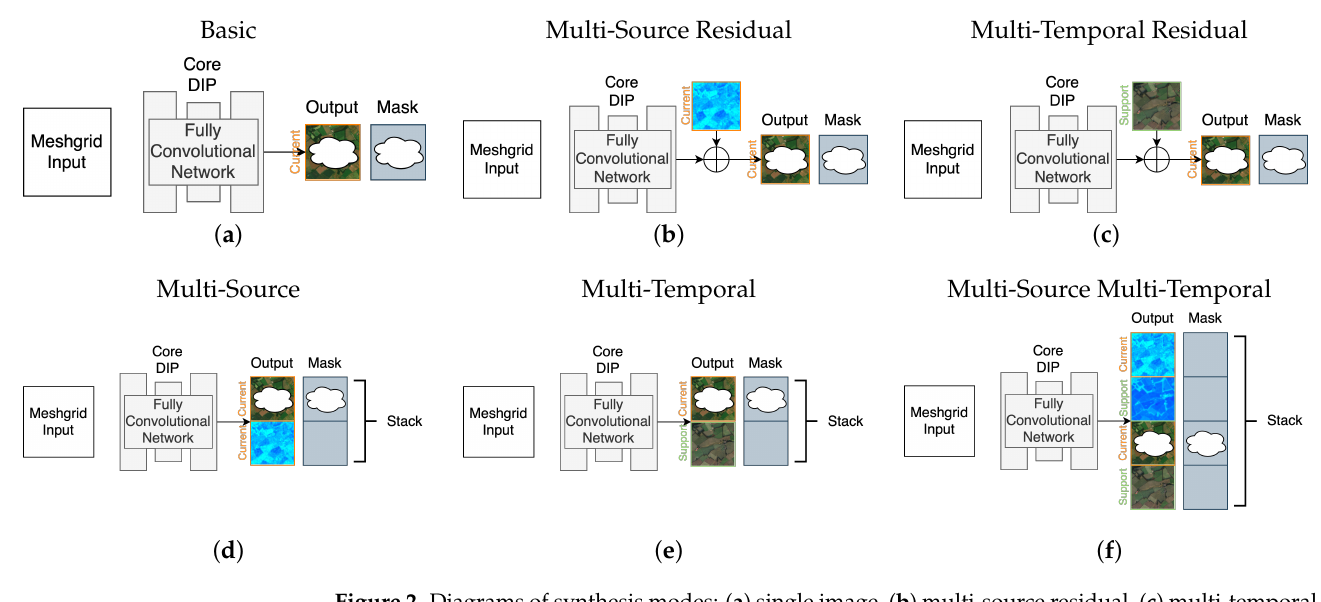
Figure 2. Diagrams of synthesis modes: ( a ) single image, ( b ) multi-source residual, ( c ) multi-temporal residual, ( d ) stacked multi-source, ( e ) stacked multi-temporal, and ( f ) stacked multi-source multi-